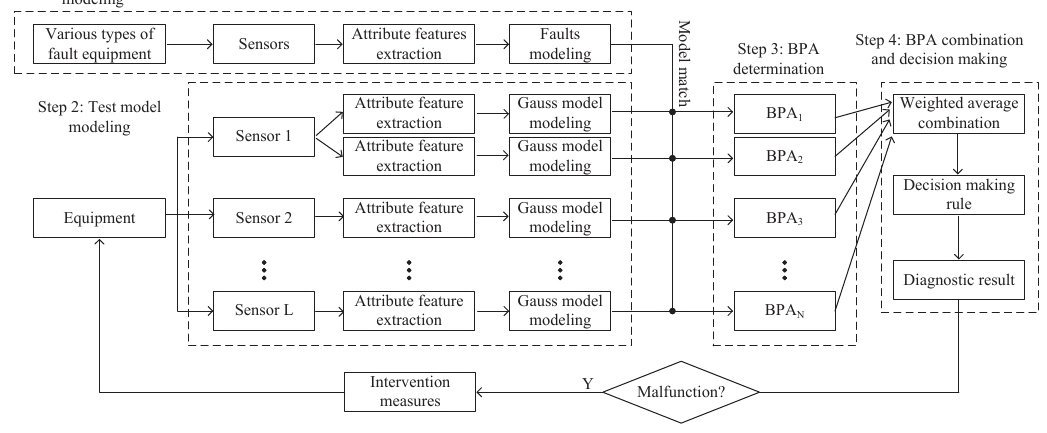
Figure 1. The procedure of fault diagnosis with the proposed